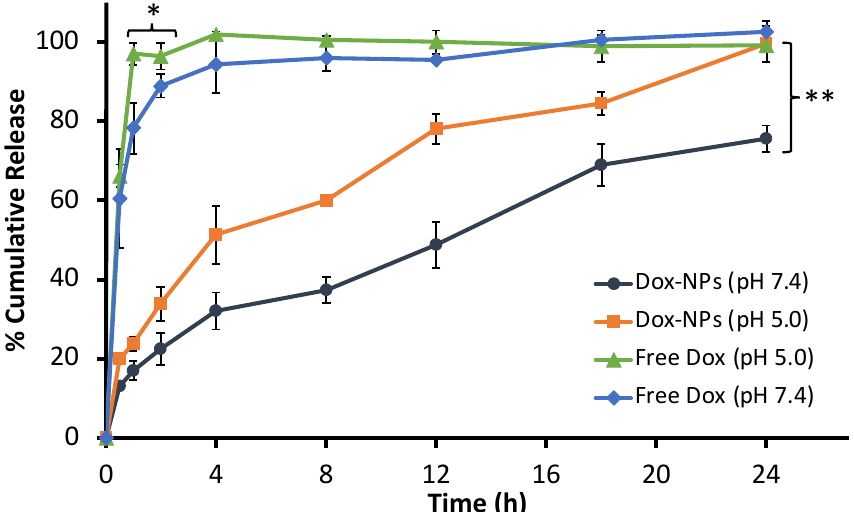
Figure 5. The release profiles of (– ∆ –) Free Dox in pH 5.0, (– (cid:7) –) Free Dox in pH 7.4, (– (cid:4) –) Dox-NPs in pH 5.0, and (– • –) Dox-NPs in pH 7.4. (* Significant difference from free Dox pH 7.4 at 95% CI, ** Significant difference from Dox-NPs pH 7.4 at 95%